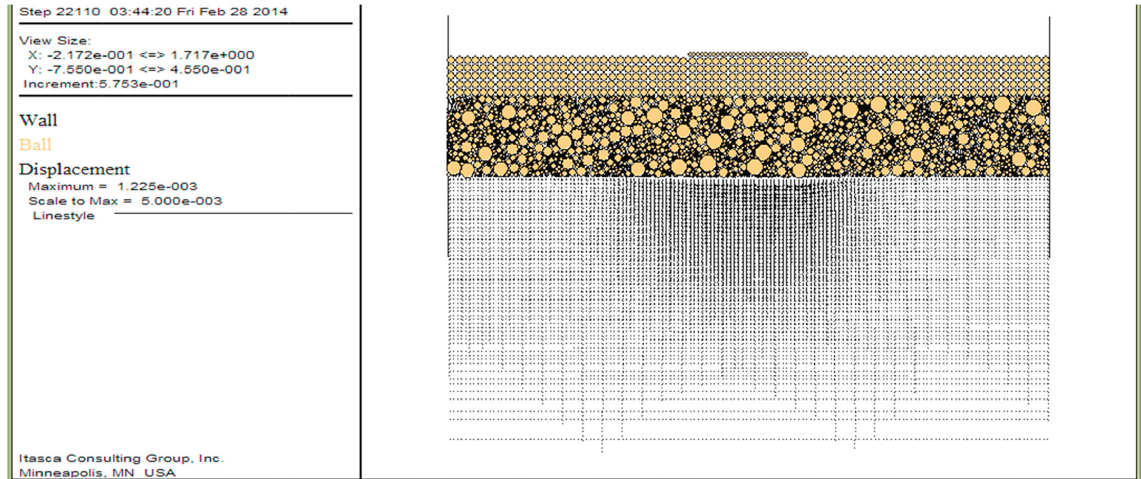
Figure 11: Deformation characteristics of the subgrade soil